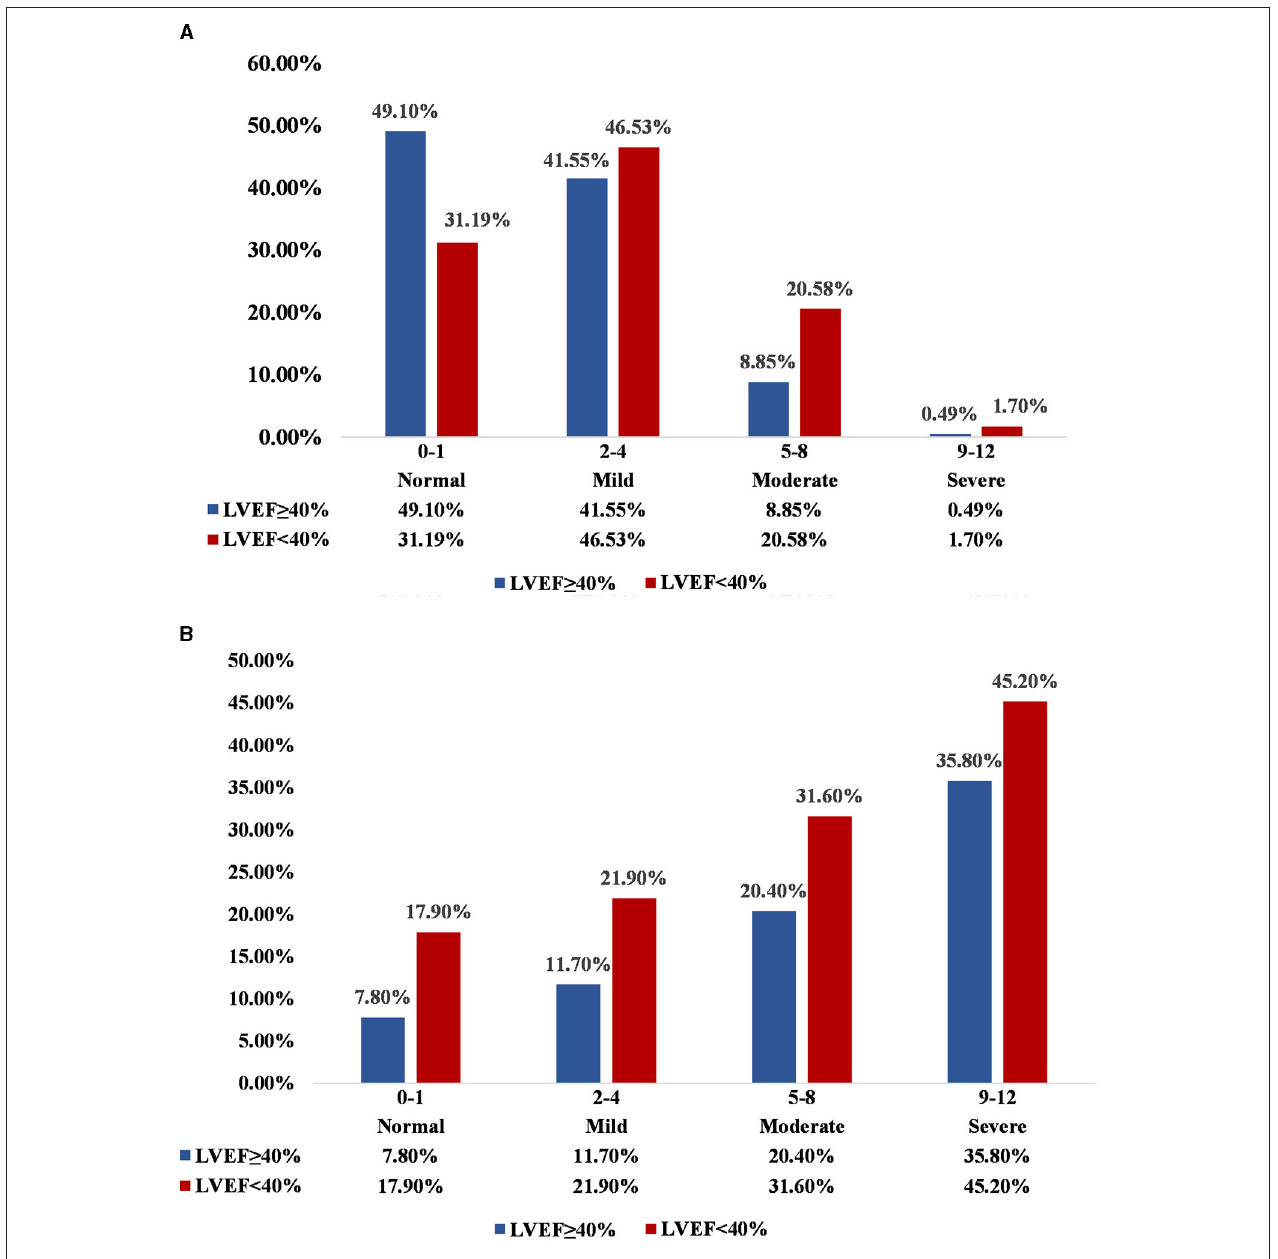
FIGURE 1 | (A) Distribution of nutritional state in LVEF ≥ 40% and LVEF < 40%; (B) Incidence of death across malnutrition and LVEF categories. Normal, Mild, Moderate, and Severe correspond to the state of malnutrition, respectively, based on the CONUT score. Normal: CONUT 0–1; Mild: CONUT 2–4; Moderate: CONUT 5–8; Severe: CONUT 9–12.